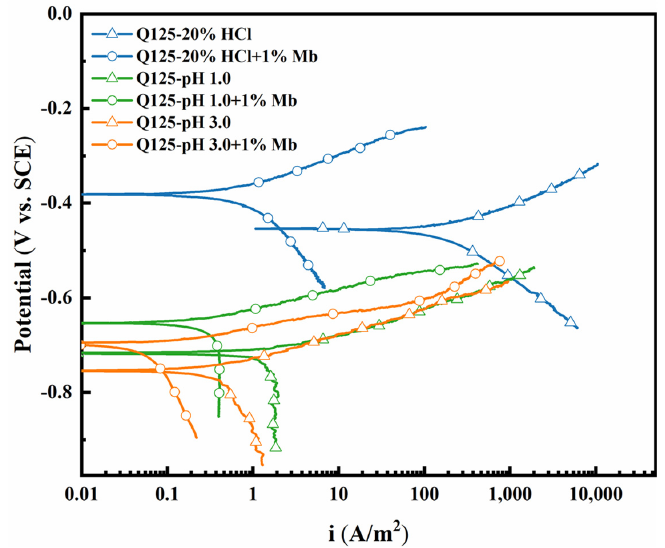
Figure 3. Polarization curves of casing steel immersed in fresh and residual acid solutions with or without Mb inhibitor for 4 h at 90 °C.